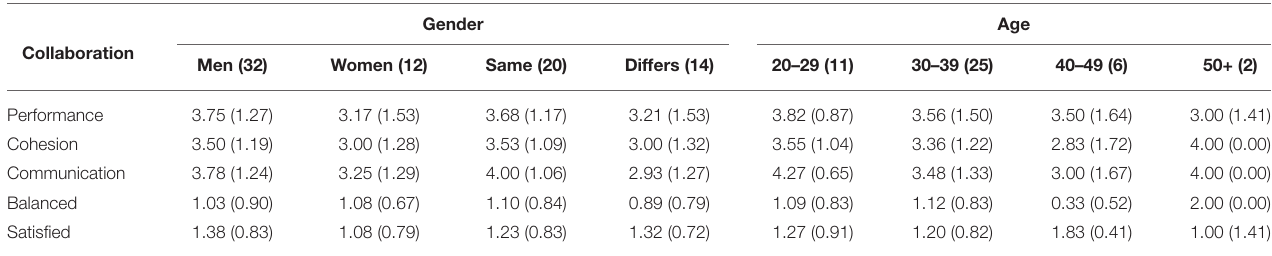
TABLE 10 | Mean (standard deviation) of collaboration quality metrics by gender and age, and also for teams that include the same or different genders.